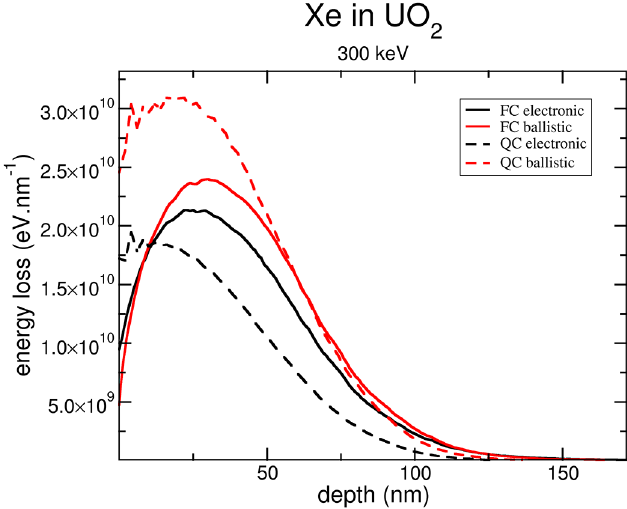
Fig. 6. Energy deposition for 300 keV Xe irradiation in UO 2 .